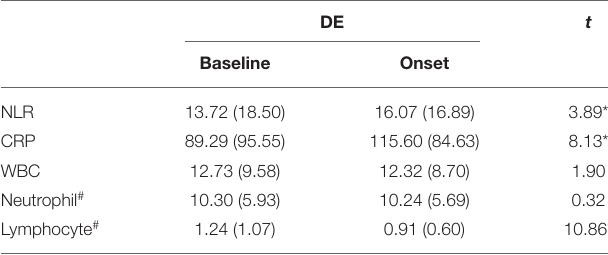
TABLE 1 | Demographic characteristics of the patients with delirium; mean (SD). TABLE 2 | Differences in inflammatory markers in DE; mean